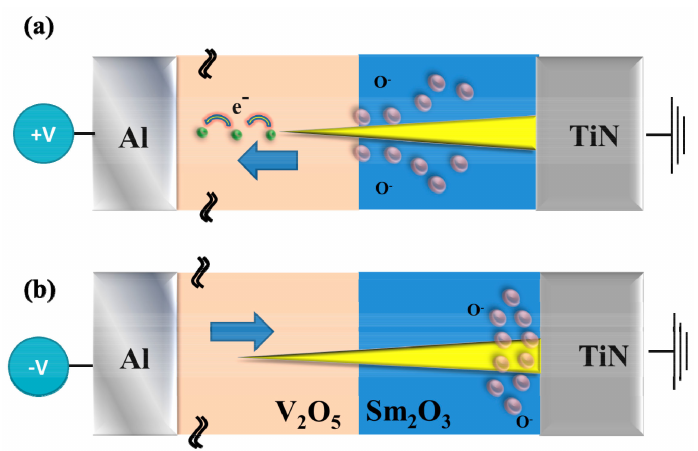
Figure 7. The electrical transfer mechanisms and initial metallic filament path models for the Al / V 2 O 5 / Sm 2 O 3 / TiN / SiO 2 / Si and Al / Sm 2 O 3 / V 2 O 5 / TiN / SiO 2 / Si devices in the ON / OFF state for the ( a ) ON and ( b ) OFF